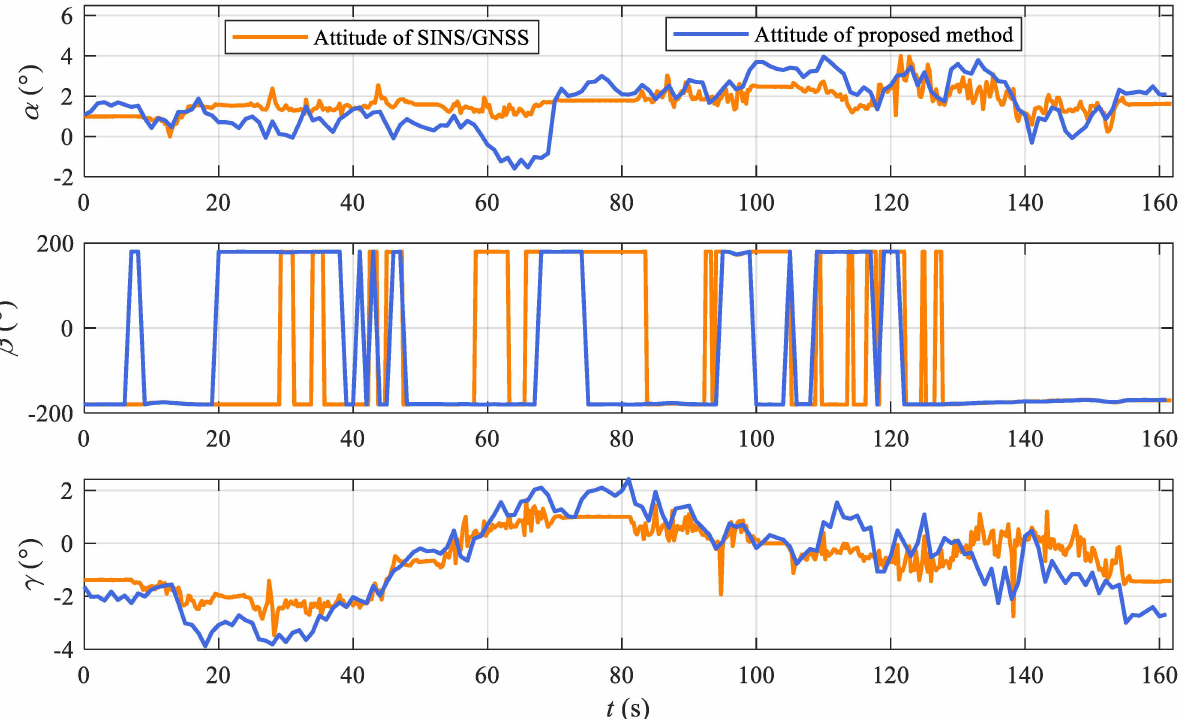
Table 3. Average attitude error and the processing time per frame of the urban road test. Area